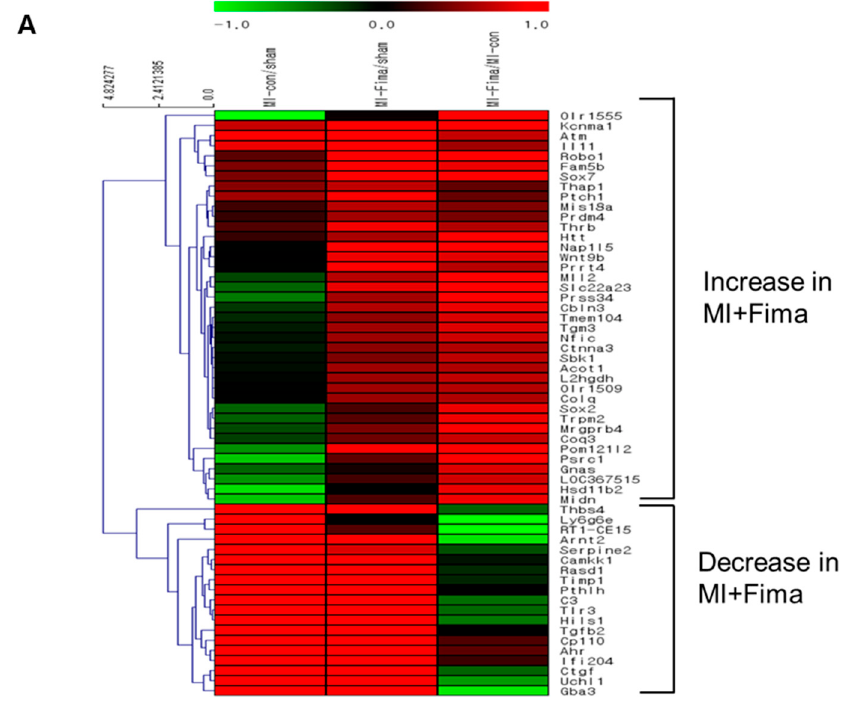
Figure 3. A histologic examination of the explanted hearts: ( A ) Cardiac hypertrophy was assessed as the heart weight/tibia length ratio. Fimasartan attenuated the induction of cardiac hypertrophy after MI. ■ , sham; ▲ , MI; ▼ , MI + Fima. ( B ) The hematoxylin and eosin (H&E) and Masson trichrome (MT) staining showed a smaller infarct size and fibrosis in the MI + Fima group. ( C ) The MI + Fima group ( ■ ) had a smaller infarct size than the MI-only group ( ● ). The P -values represent * P < 0.05, and ** P < 0.01. The results are expressed as mean ±